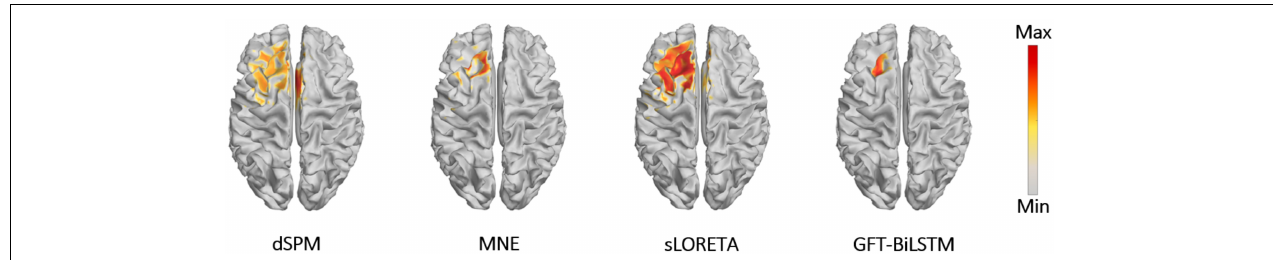
FIGURE 10 | Reconstructed sources by different ESI algorithms for epilepsy EEG